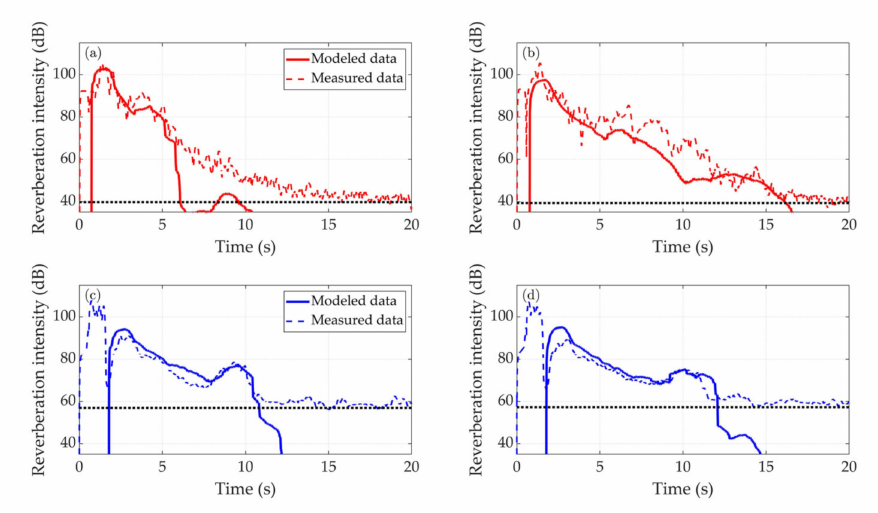
Figure 12. Comparison of the modeled reverberation intensity and the data at both broadsides for ping 107 and ping 324. ( a ) 90 ◦ for ping 107, ( b ) 270 ◦ for ping 107, ( c ) 90 ◦ for ping 324, and ( d ) 270 ◦ for ping